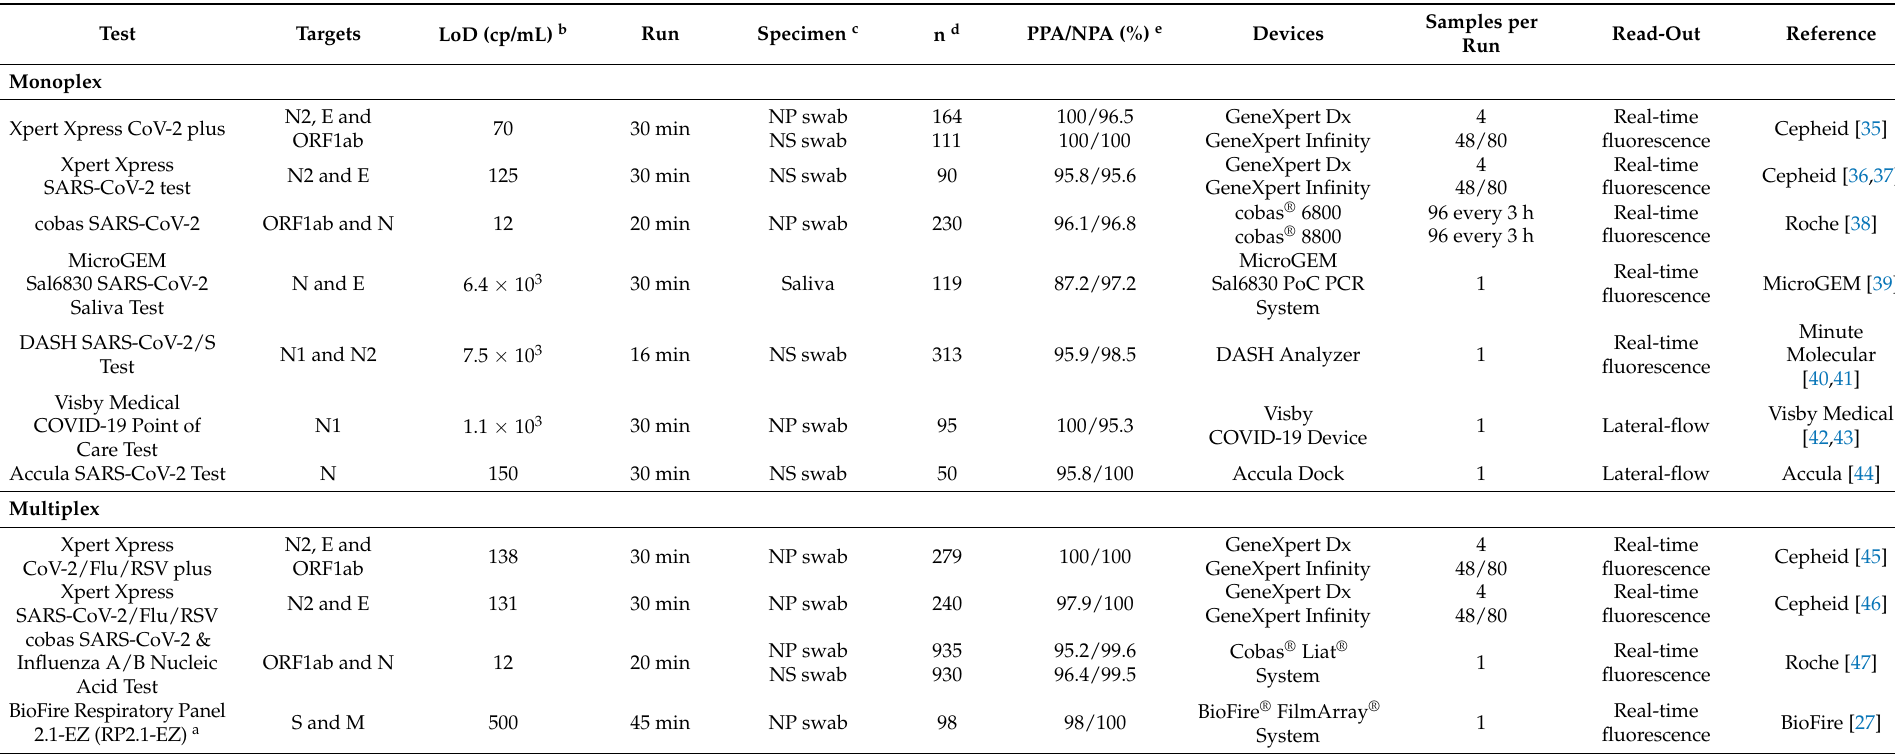
Table 1. RT-PCR tests for SARS-CoV-2 detection approved for use under a Clinical Laboratory Improvement Amendments (CLIA)